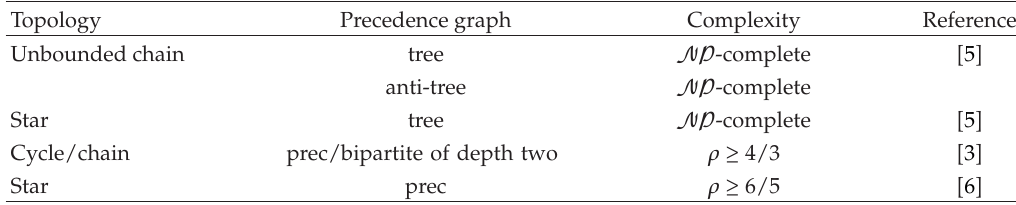
Table 1: Previous complexity results on the processors network